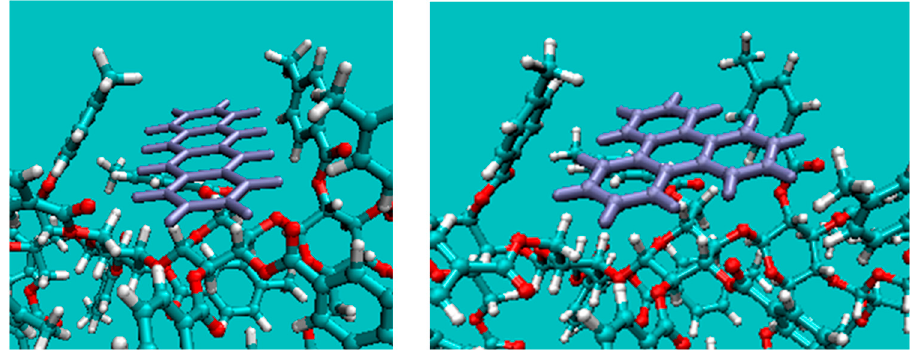
Figure 4. The predicted association of cellulose tris(4-methylbenzoate) respectively with naphthacene ( left ) and triphenylene ( right ).